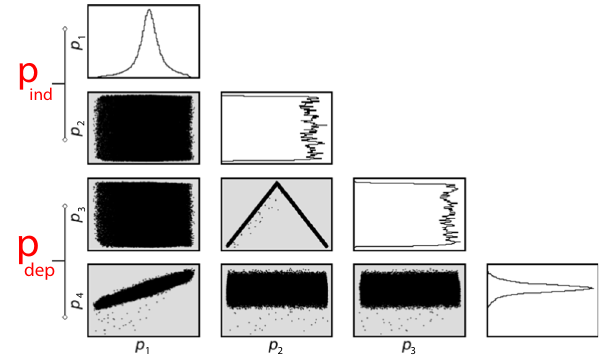
Fig. 1 An example of distribution of the points in T in the projection space from Sect. 3. In this particular case, the projection space is in R 4 . We decided to set k (cid:3) = 2, thus describing the points distribution in R 4 with two curves: p 3 = f 3 ( p 1 , p 2 ) and p 4 = f 4 ( p 1 , p 2